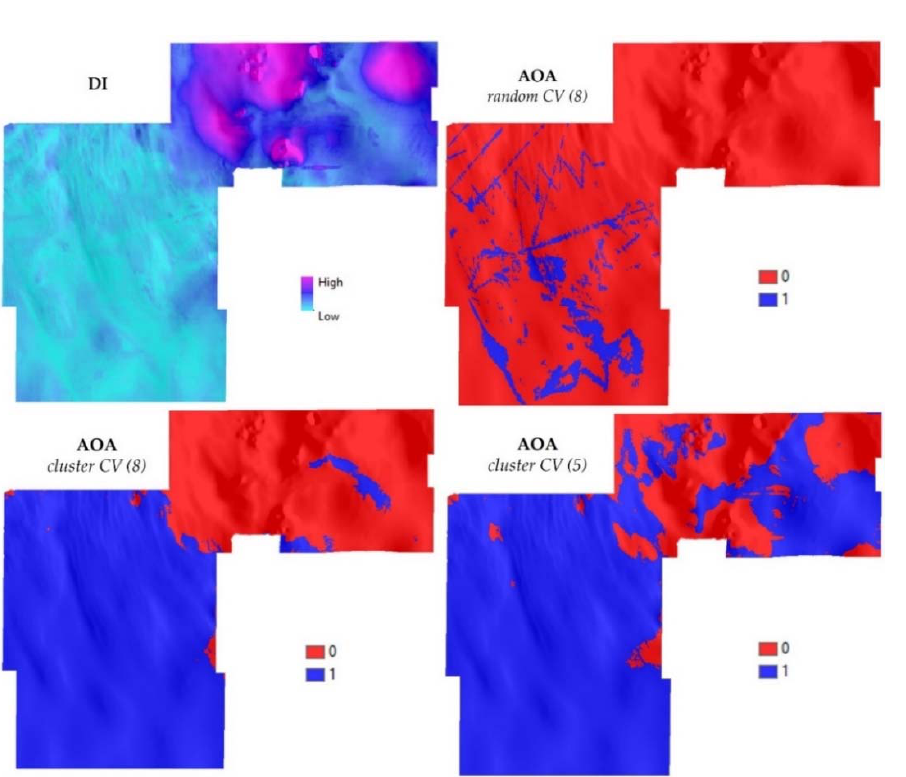
Figure 11. Top left: the dissimilarity index (DI) between training samples and the study area resulted from the QRF model weights. Top right: the random-CV has the most limited AOA, which is re- stricted to the area directly around the training samples. For block- and cluster-CV (middle left), the prediction error is comparable for the entire DEA and a small part of the DEA-NE (0 = Not applica- ble, 1 = Applicable). Without the mean depth (MD) as predictor variable, the AOA increases (middle right). The spatial- and cluster-CV have very similar AOA statistic values (r = 0.96 p < 2.2 × 10 − 16 ). Thus, only the cluster-CV AOA is presented in the density plots (bottom). The density plots show the difference between the training samples (blue) and the entire study area (red). Mean depth (MD) has the most significant difference, followed by backscatter (BS), northness (N), and eastness (E). 4. Discussion This article presents a PMN prediction case study based on AUV hydroacoustic and image data from the Peru Basin in the Pacific. The study highlights the presence of spatial autocorrelation within the polymetallic nodule (PMN) distribution, with the PMN being spatially aggregated due to local geomorphological settings and the prevailing bottom current regime. The northwest oriented bottom current is channeled through abyssal fur- rows and erodes fine sediments. This leaves abundant fragmental materials (fish teeth,